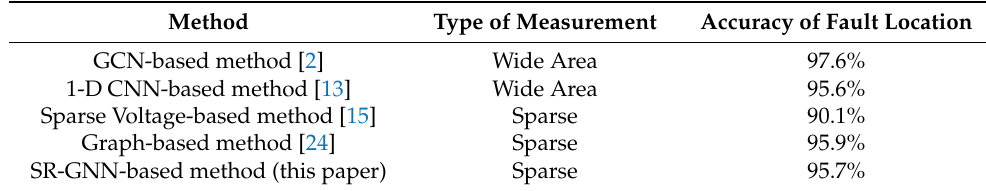
Table 7. Comparison results with existing advanced